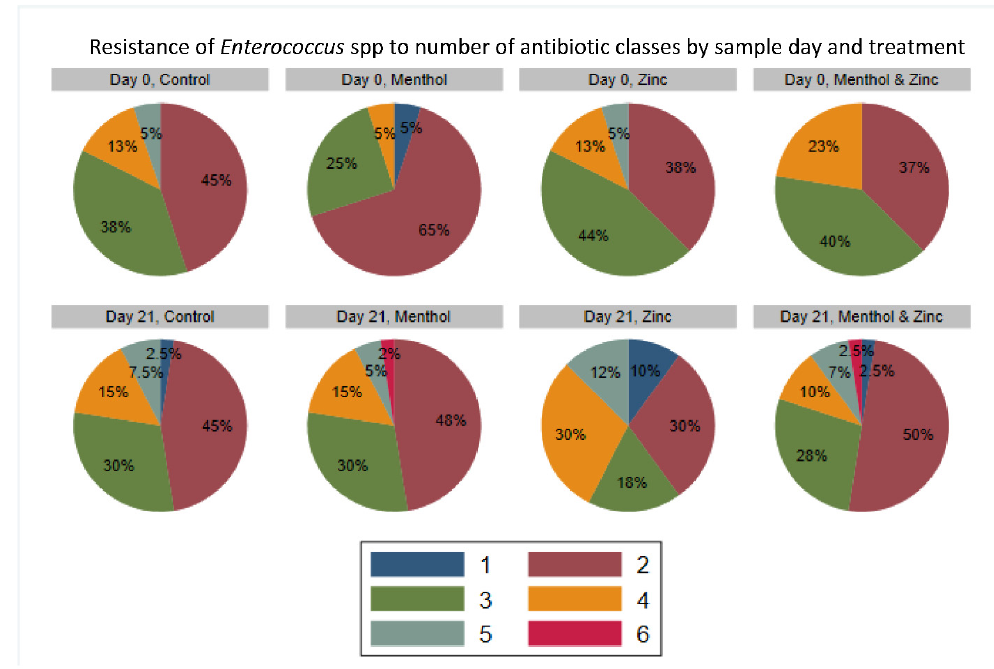
Figure 11. Resistance (%) of Enterococcus spp. isolates to number of antibiotic classes by sample day and treatment. Each color indicates the percentage of isolates resistant to the specified number of antibiotic classes (out of 13).